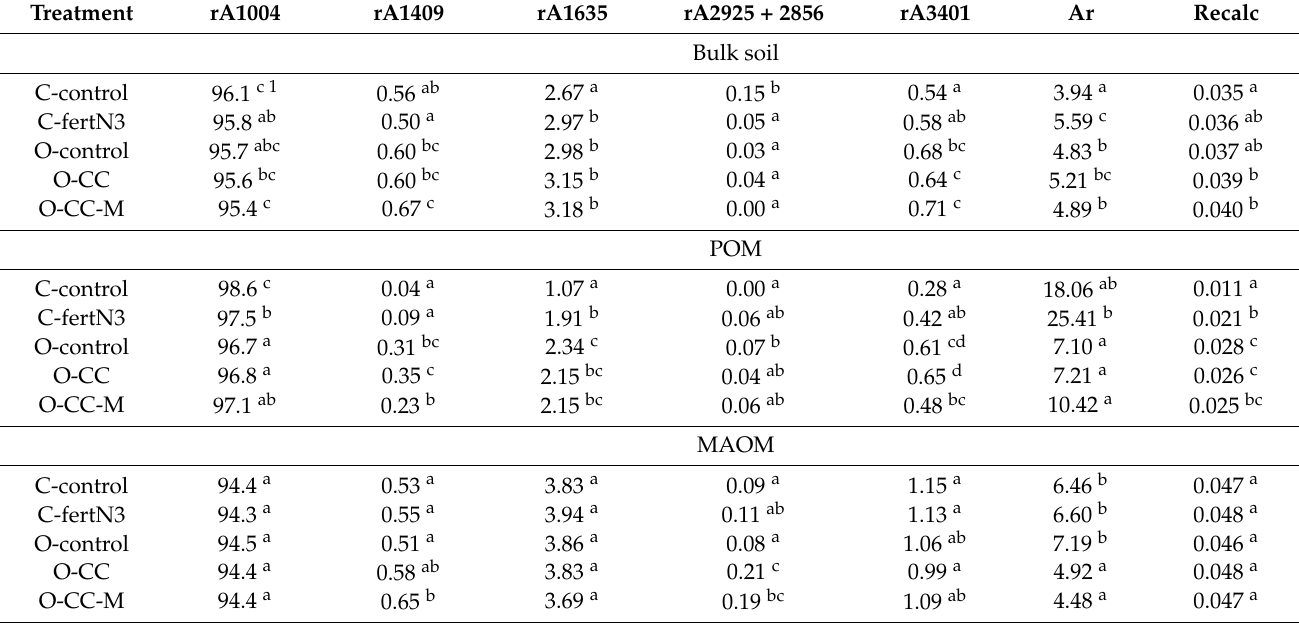
Table 8. Relative absorbances (rA) in the percentage of the sum of all selected peak heights of the FTIR spectra, aromaticity (Ar), and recalcitrance (Recalc) of bulk soil, particulate organic matter (POM), and mineral-associated organic matter (MAOM) of different